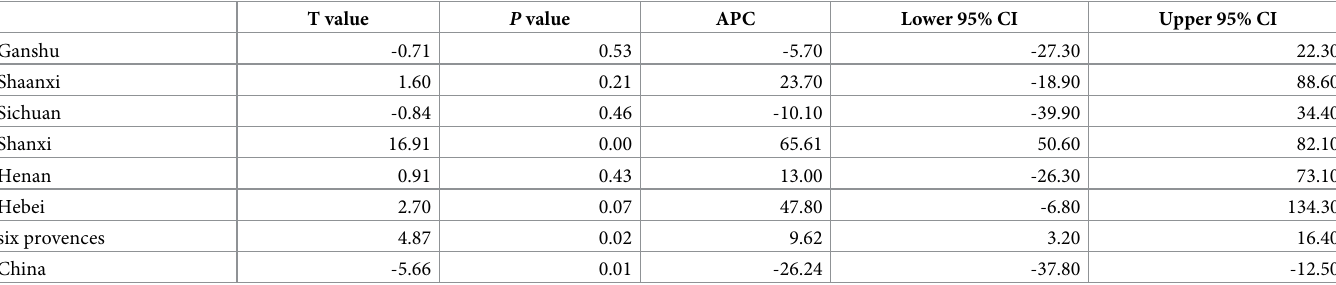
Table 1. Joinpoint regression analysis of mountain-type zoonotic visceral leishmaniasis incidence in 6 provences, China from 2015 to 2019. T